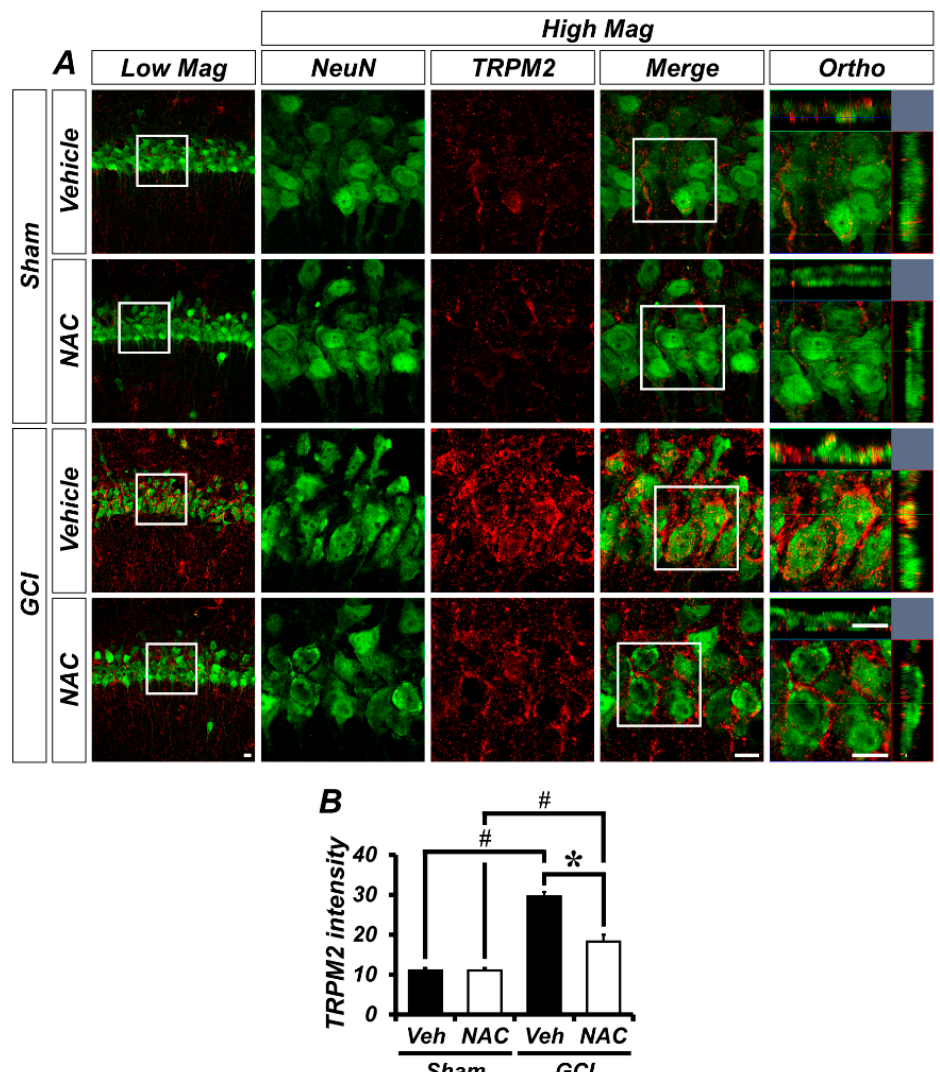
Figure 4. GCI ‐ induced transient receptor potential melastatin 2 (TRPM2) activation was attenuated by NAC treatment. ( A ) Representative histological images of TRPM2 ‐ positive signal in the hippocampal CA1. The neuronal TRPM2 level was remarkably increased in the GCI–vehicle group and NAC administration after GCI reduced TRPM2 activation. Scale bar = 20 μ m. ( B ) Bar graph shows intensity of TRPM2 ‐ positive signal (red color) within the hippocampal pyramidal layer. Data are mean ± SEM, n = 5 each group, * p < 0.05 versus vehicle ‐ treated group; # p < 0.05 versus sham ‐ operated group (Kruskal–Wallis test followed by Bonferroni post ‐ hoc test: chi square = 16.097, df = 3, p = 0.001).